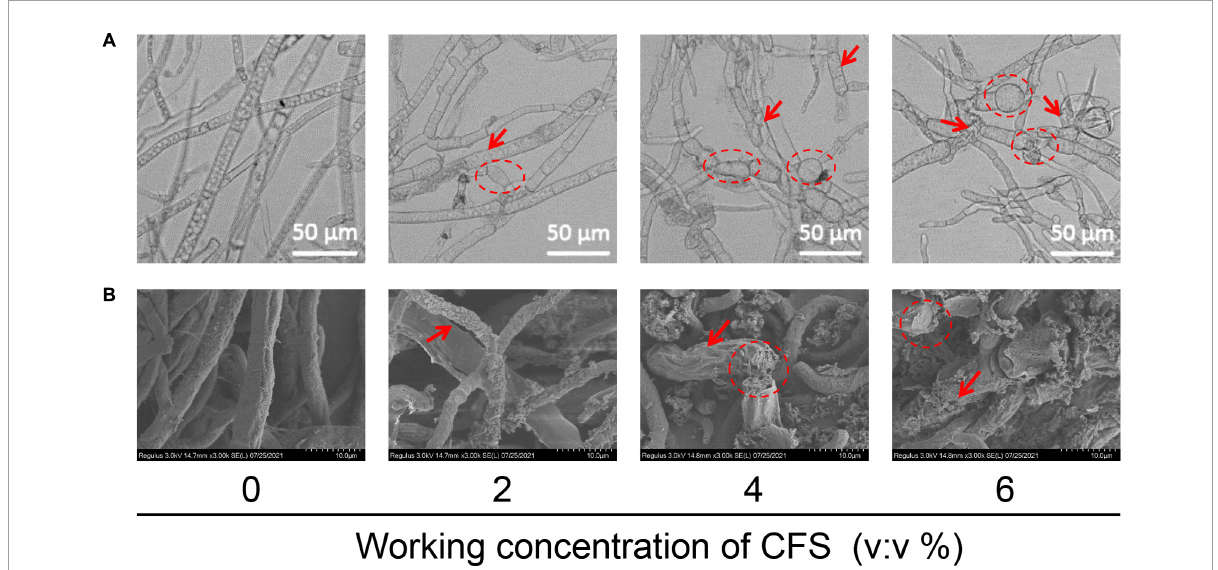
FIGURE5 Effects of cell-free supernatant (CFS) on the morphological structure of Botrytis cinerea . (A) Effects of CFS on the morphological structure of B. cinerea were tested in a PDB medium containing a different working concentration of CFS. The hyphae were collected after 24 h of treatment and images were recorded using the microscope. (B) Scanning electron micrographs of B. cinerea treated with CFS at different working